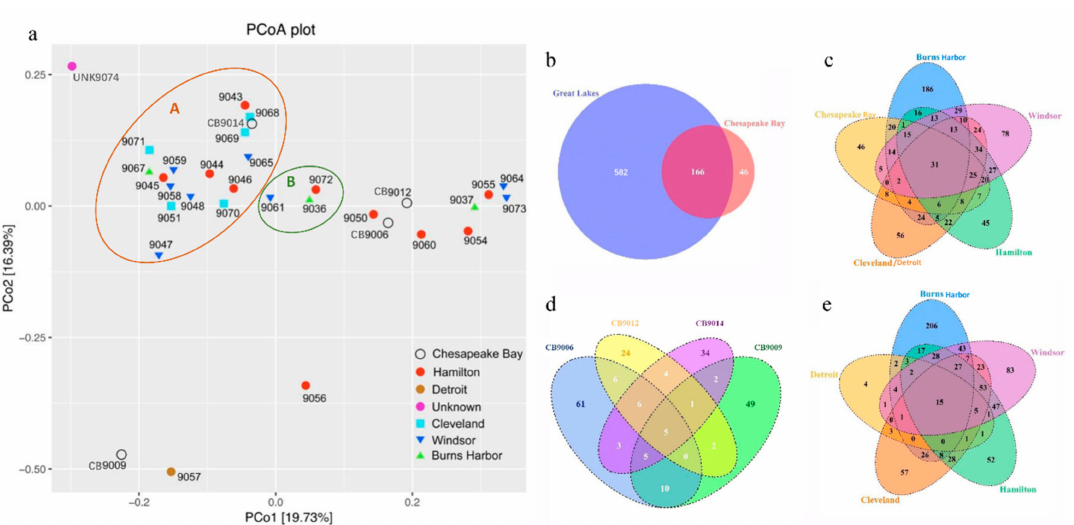
Figure 1. Principal coordinates analysis plot. ( a ) Venn diagrams (b–e) of dinoflagellate taxa at the OTU level in sediments from ships’ ballast tanks. (a) All 32 samples; ( b ) Chesapeake Bay (4 samples) and Great Lakes (27 samples); ( c ) Chesapeake Bay (4 samples), Burns Harbor (3 samples), Cleveland /